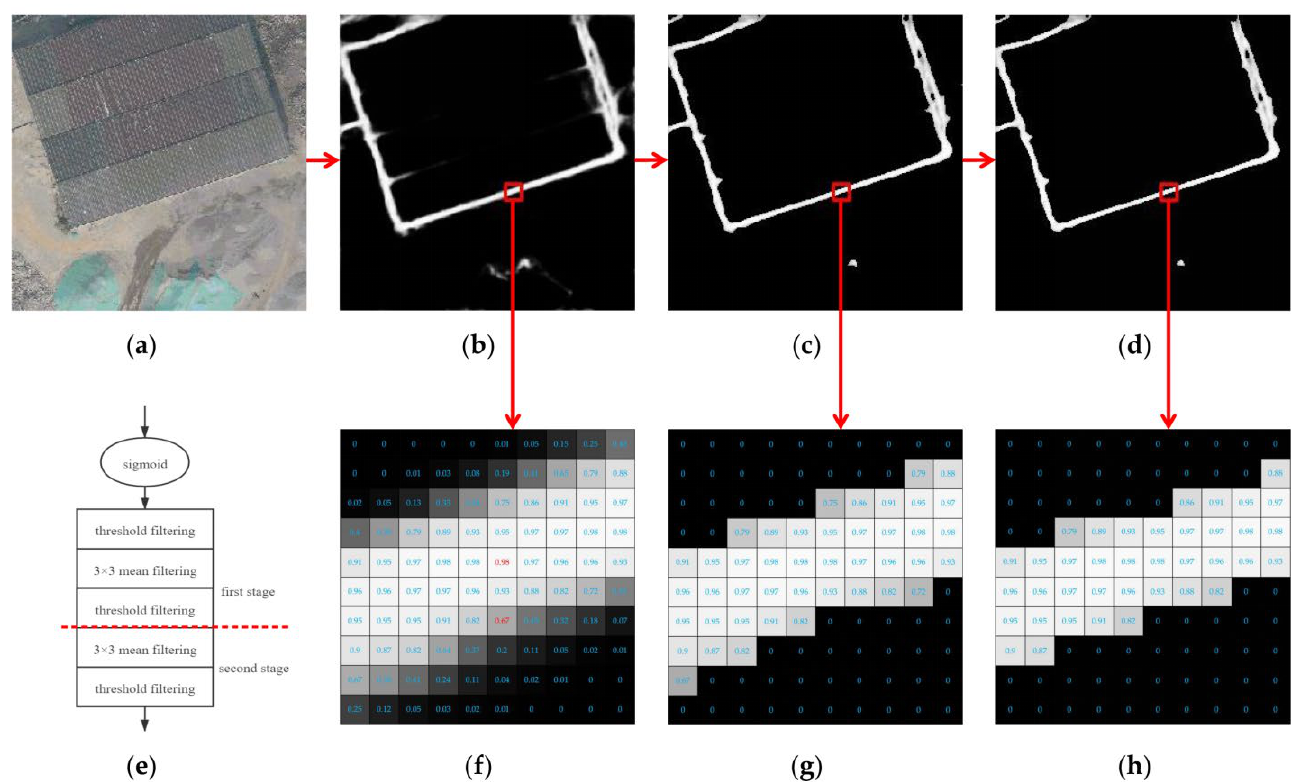
Figure 6. The erosion module (EM) and an example of Jiangbei building edge dataset: ( a ) original image; ( b ) the building edge probability map before EM; ( c ) the output after the first stage of EM; ( d ) the output after the second stage of EM; ( e ) the details of EM; ( f–h ) enlargements of red boxed areas in ( b–d ).